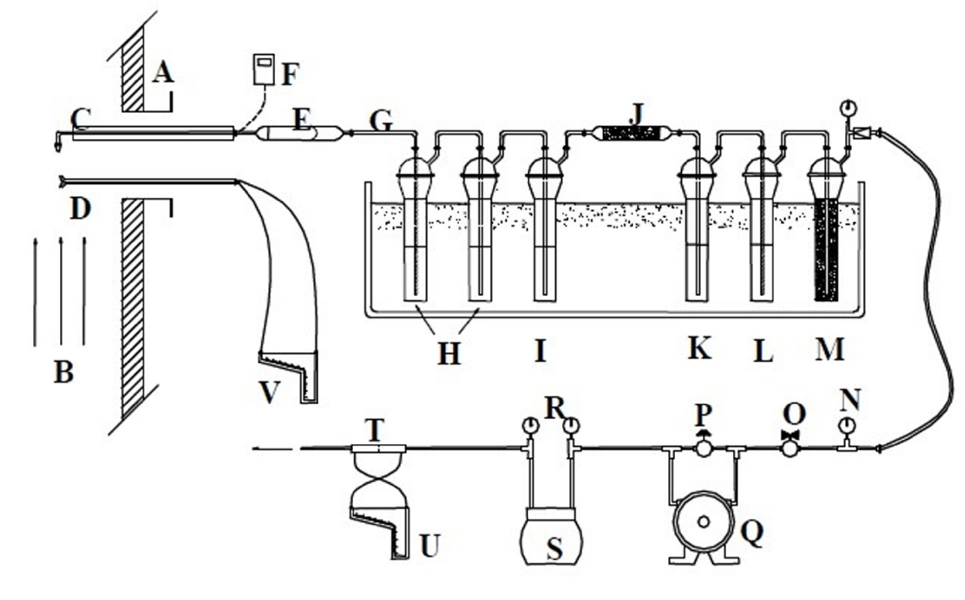
Figure 1. Schematic diagram of stack sampler.